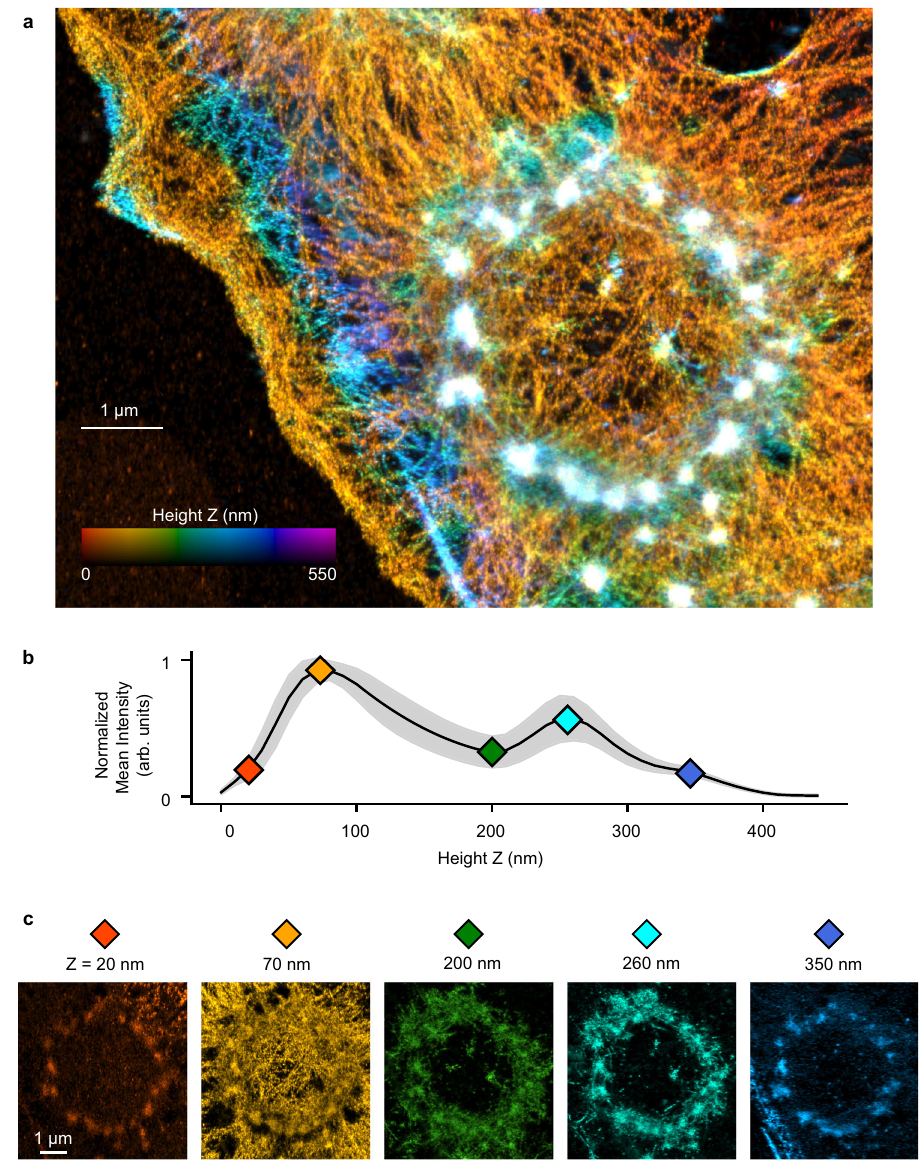
Fig. 2 | iPALM imaging of actin in frustrated phagocytosis. a Color coded Z-projection of a frustrated phagocytosis site. Color scale indicates distance of actin from coverslip (Phalloidin Alexa 647). b Normalized actin intensity for